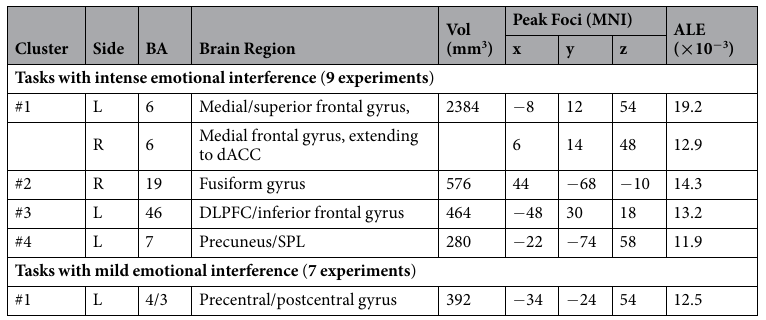
Table 2. Brain activation underlying emotional interference on cognitive control during intense versus mild emotional interference. dACC: dorsal anterior cingulate cortex; DLPFC: dorsolateral prefrontal cortex; SPL: superior parietal